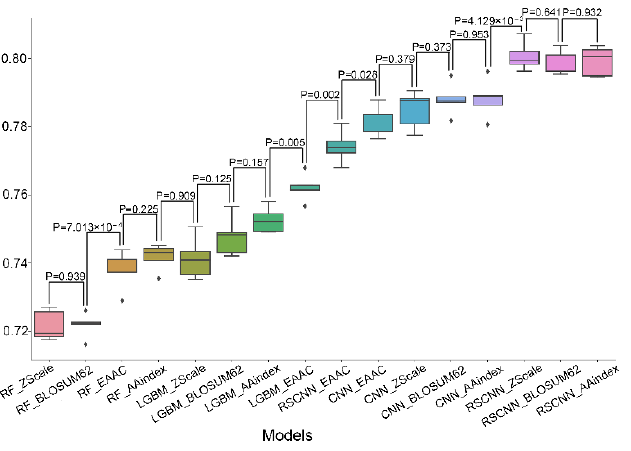
Figure 4. AUC values of different classifiers in terms of five-fold cross-validation. The classifiers are displayed in ascending order of AUC values. The statistical differences between the neighboring classifiers were calculated using paired Student t -test. The name for each model is a combination of the names of the involved algorithm and the encoding